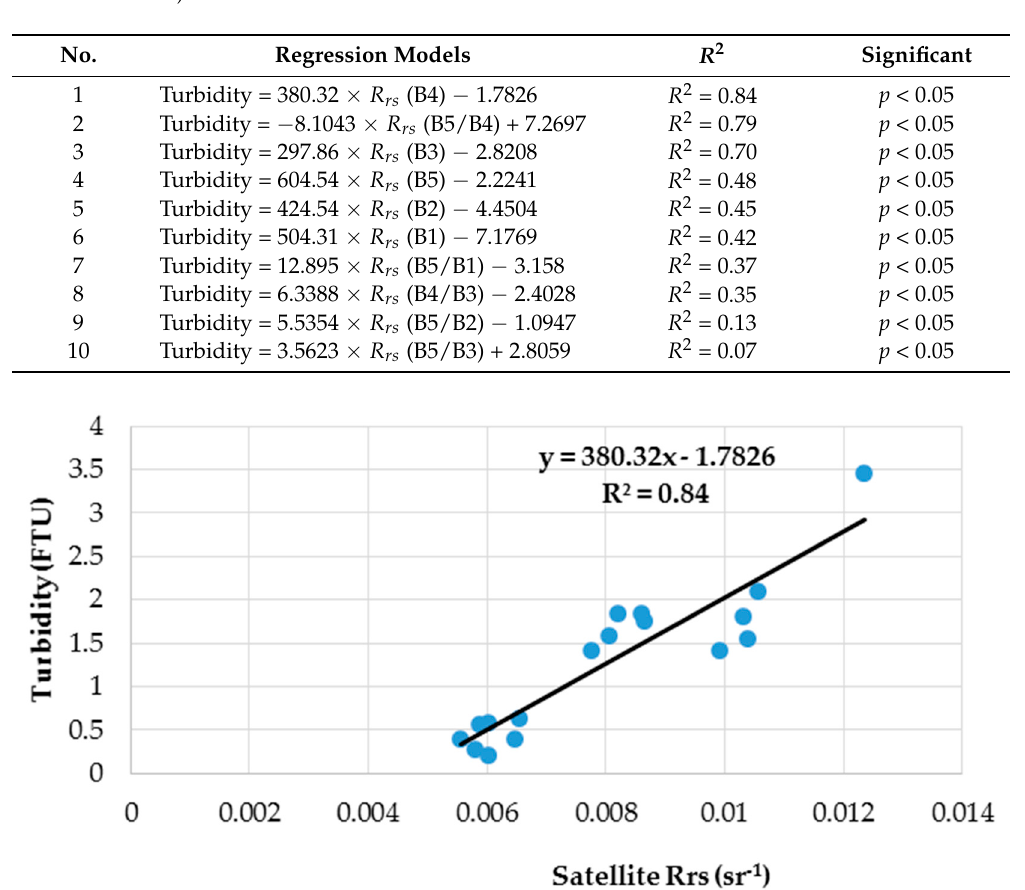
Table 5. Regression models for turbidity retrieval (B1 = 433 nm, B2 = 482 nm, B3 = 562 nm, B4 = 655 nm and B5 = 865 nm).